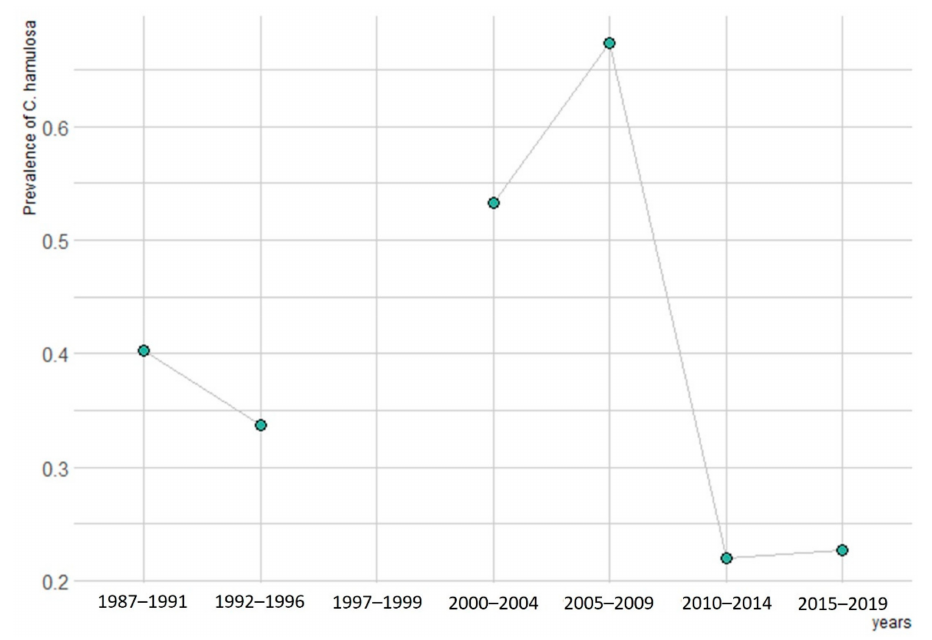
Figure 1. Five-year aggregated prevalence of C. hamulosa in the rock partridge during the period 1987–2019 (1997–1999 excluded due to the absence of samples) in the French Alps. Years are represented on the x -axis, and prevalence values on the y